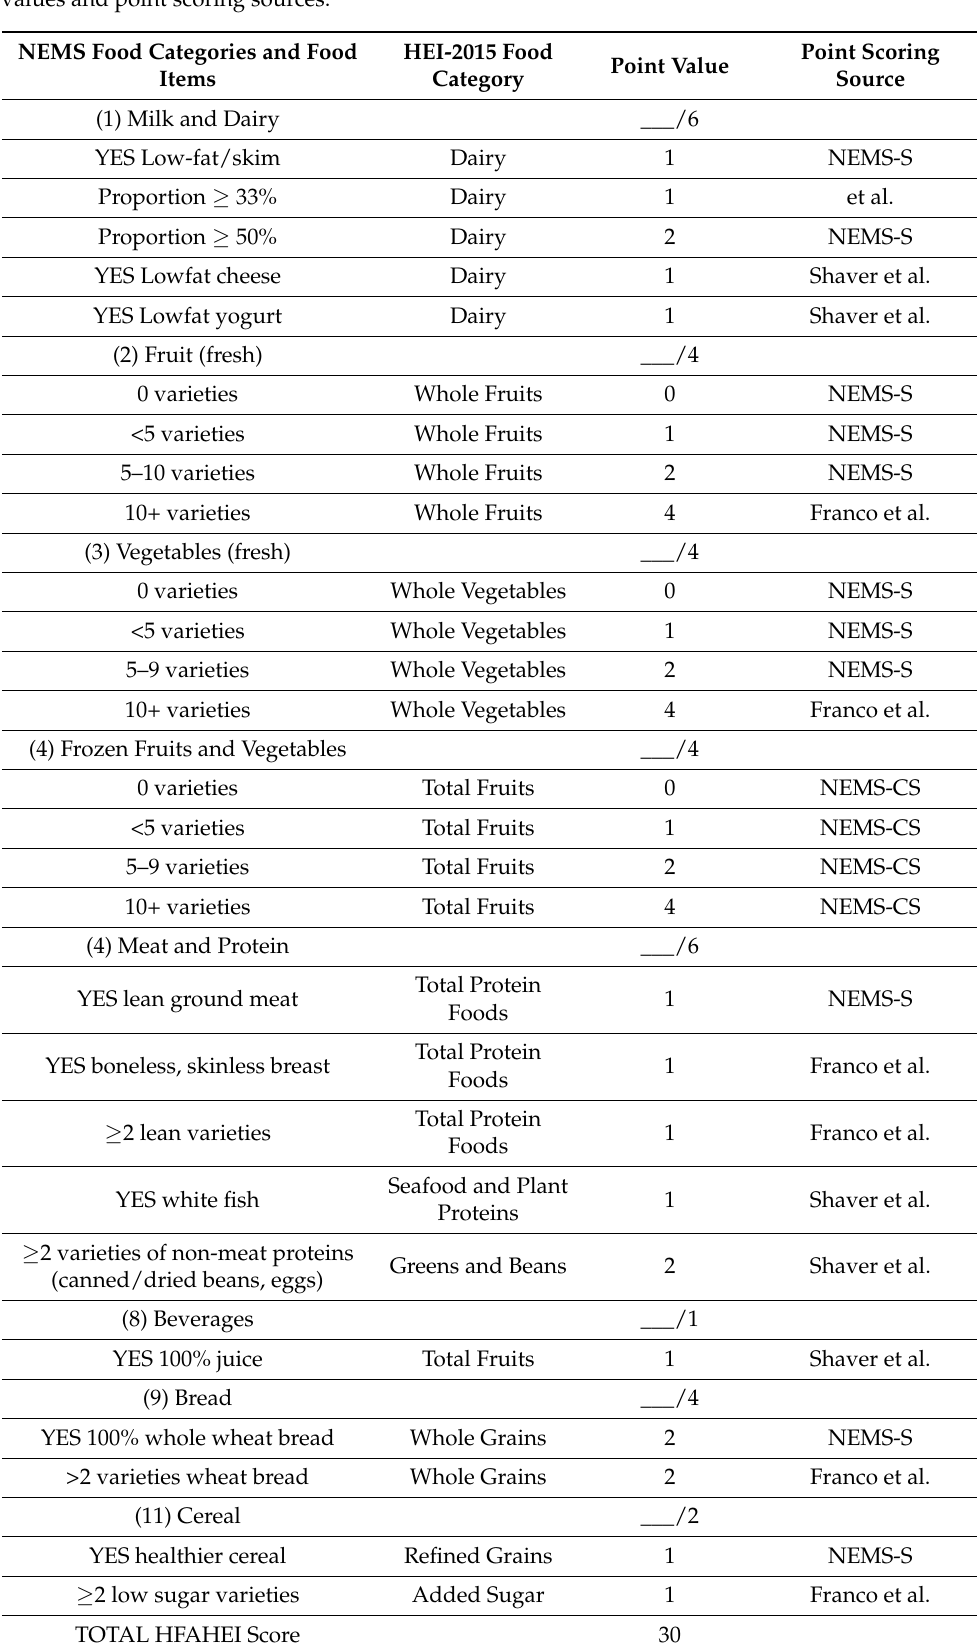
Table 1. NEMS categories and food items aligned with Healthy Eating Index categories with point values and point scoring